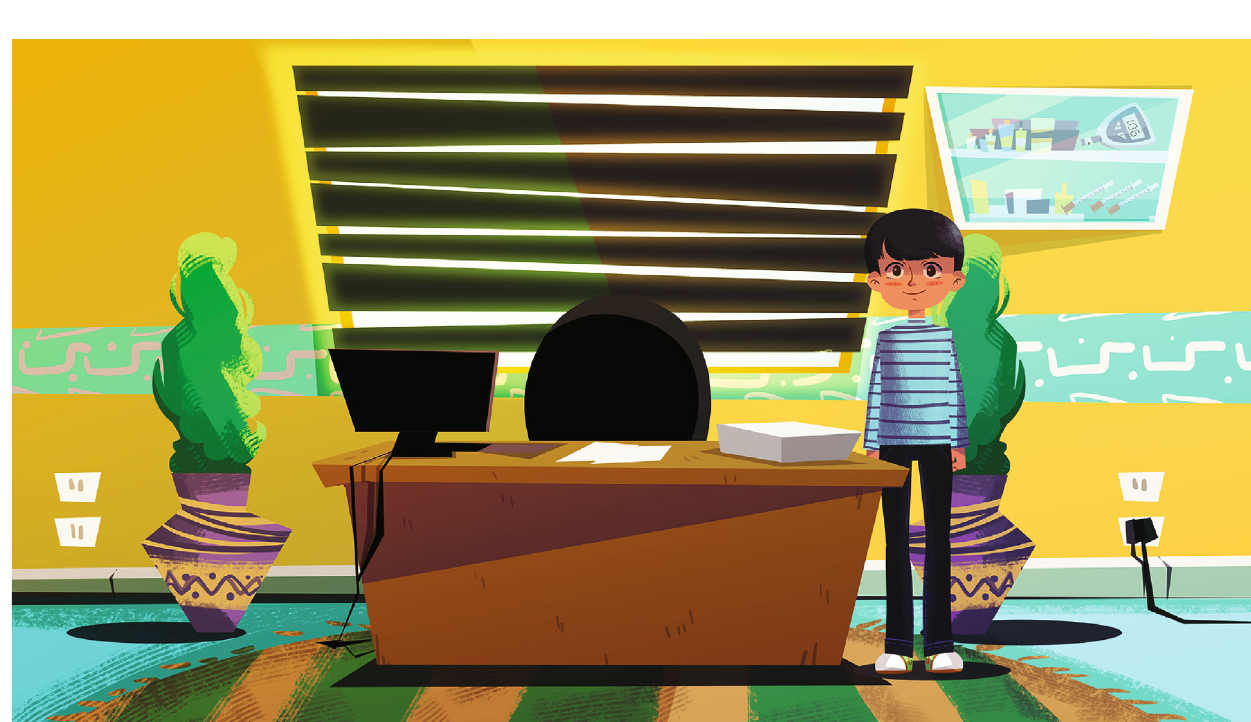
Figure 8: Insulin